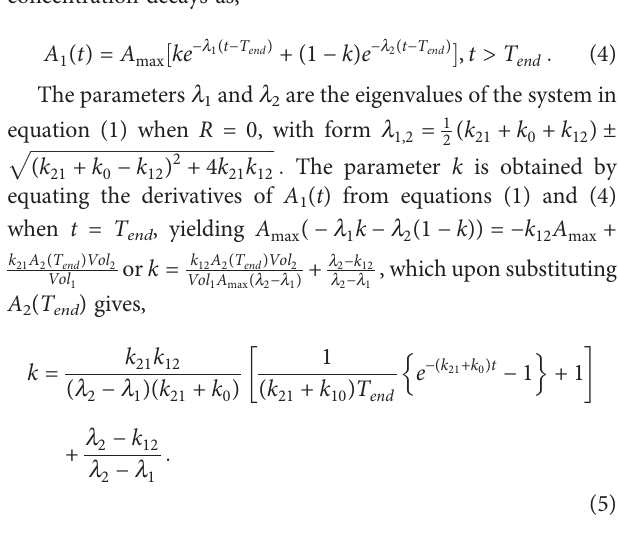
(see Table S1 21